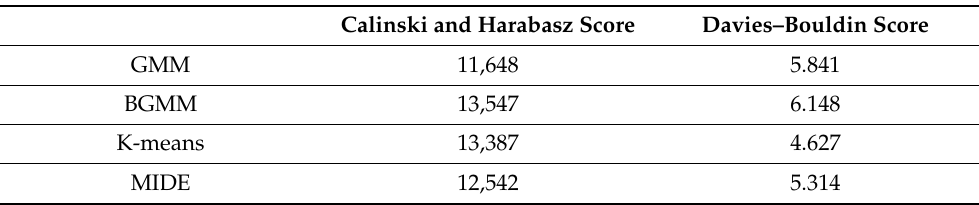
Table 2. Different models (means and standard deviation) were compared based on the Calinski and Harabasz score and the Davies–Bouldin score for 100